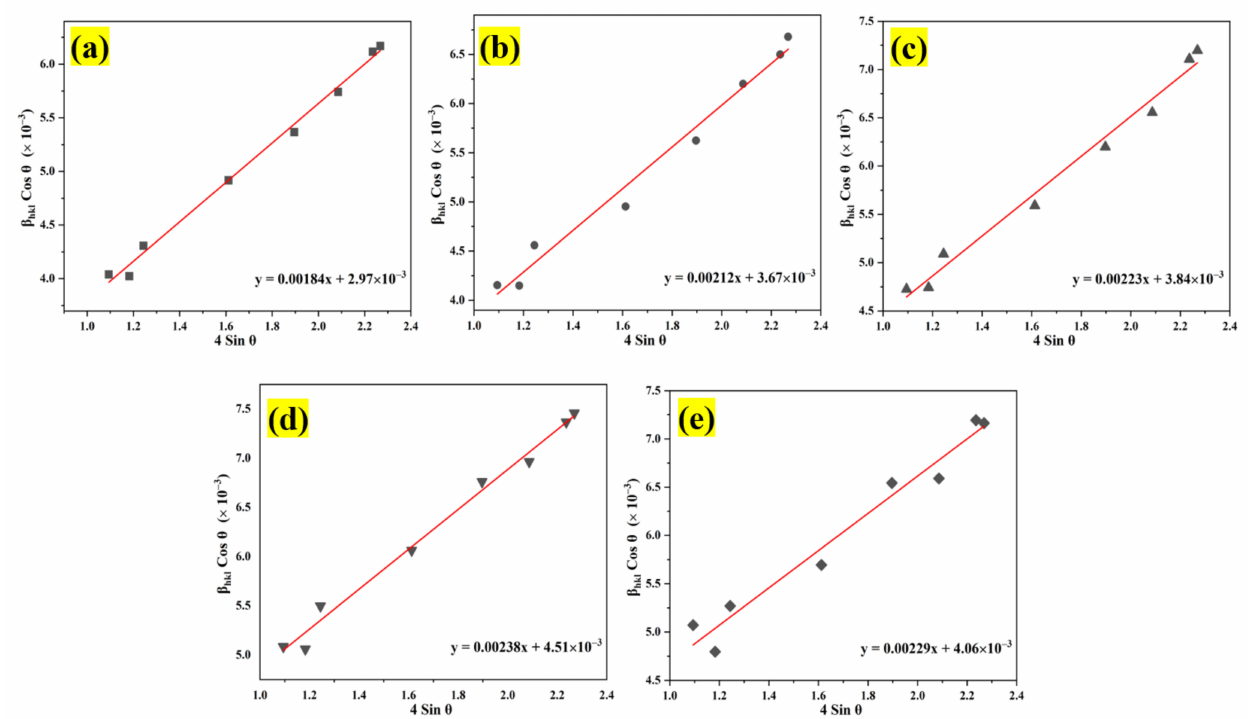
Figure 5. Analysis of the Williamson–Hall uniform deformation model (WH-UDM) for the pristine ZnO and Al:ZnO nanostructures with different immersion times: ( a ) WH-UDM of pristine